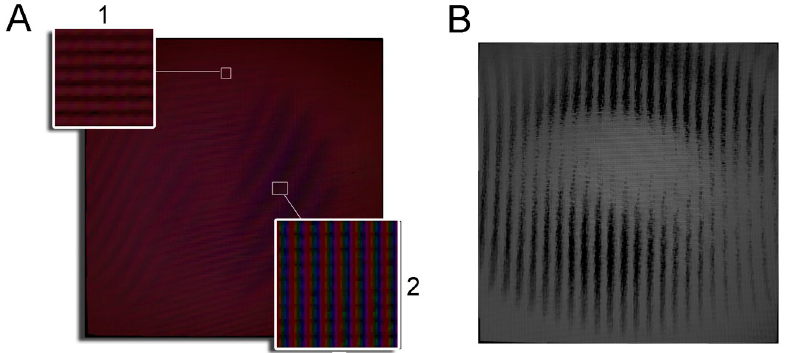
Fig 4. Texel colour dispersion. A: Three images were taken with no diffuser, one with each displayed texel illuminated in red, another with all the texels displayed in green and another one, all blue. All these captures was merged in this image at three layers, RGB. Thus we can see for each image pixel how much of each wavelength is affected individually (pseudo-colour image). B: Image captured after eight control loop iterations with no diffuser.